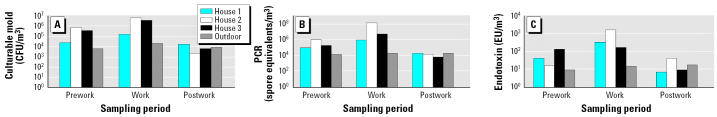
Results of filter samples from the three houses using three different analytical methods: total culturable mold (A; results are shown only for those grown on malt extract agar and cultured at 25°C), PCR (B), and endotoxin (C). Work for house 1 is the average of two measurements (upstairs and downstairs); outdoor prework is represented only by house 3; outdoor work is represented only by house 2; and outdoor postwork represents the average of the three houses.